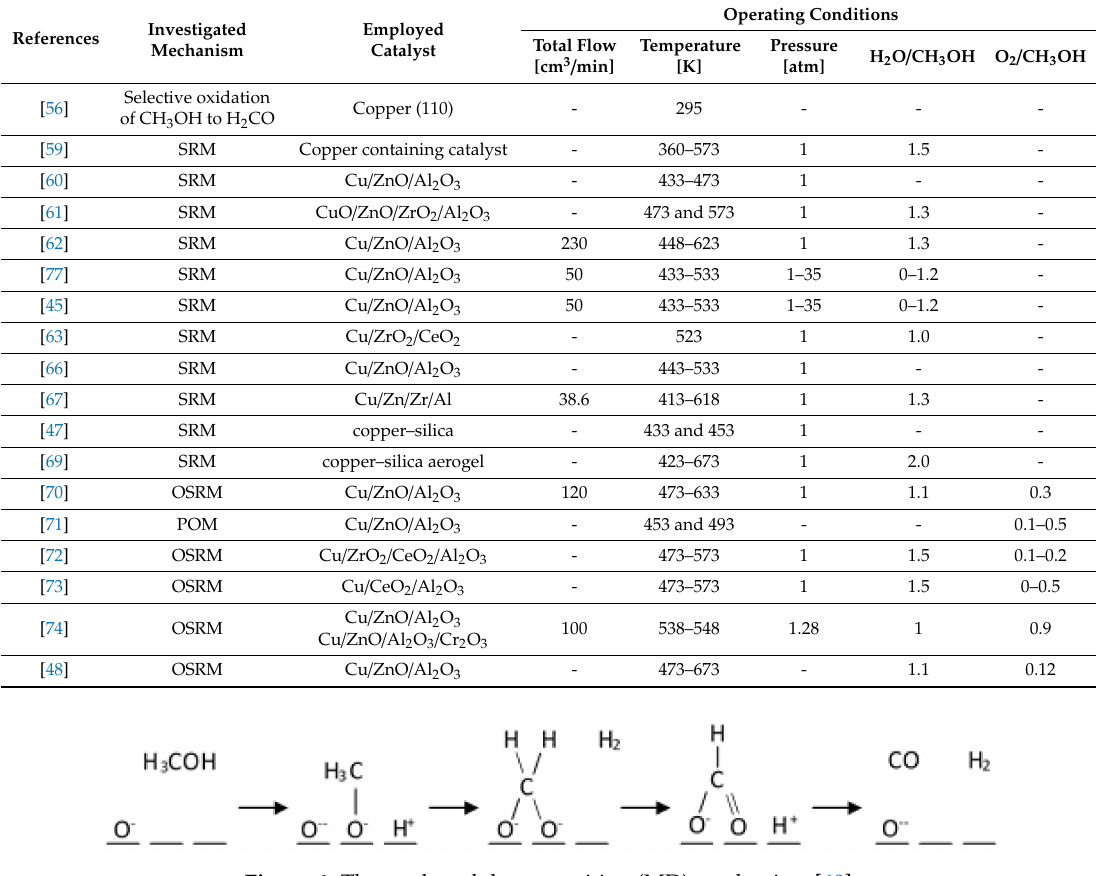
Figure 6. The methanol decomposition (MD) mechanism